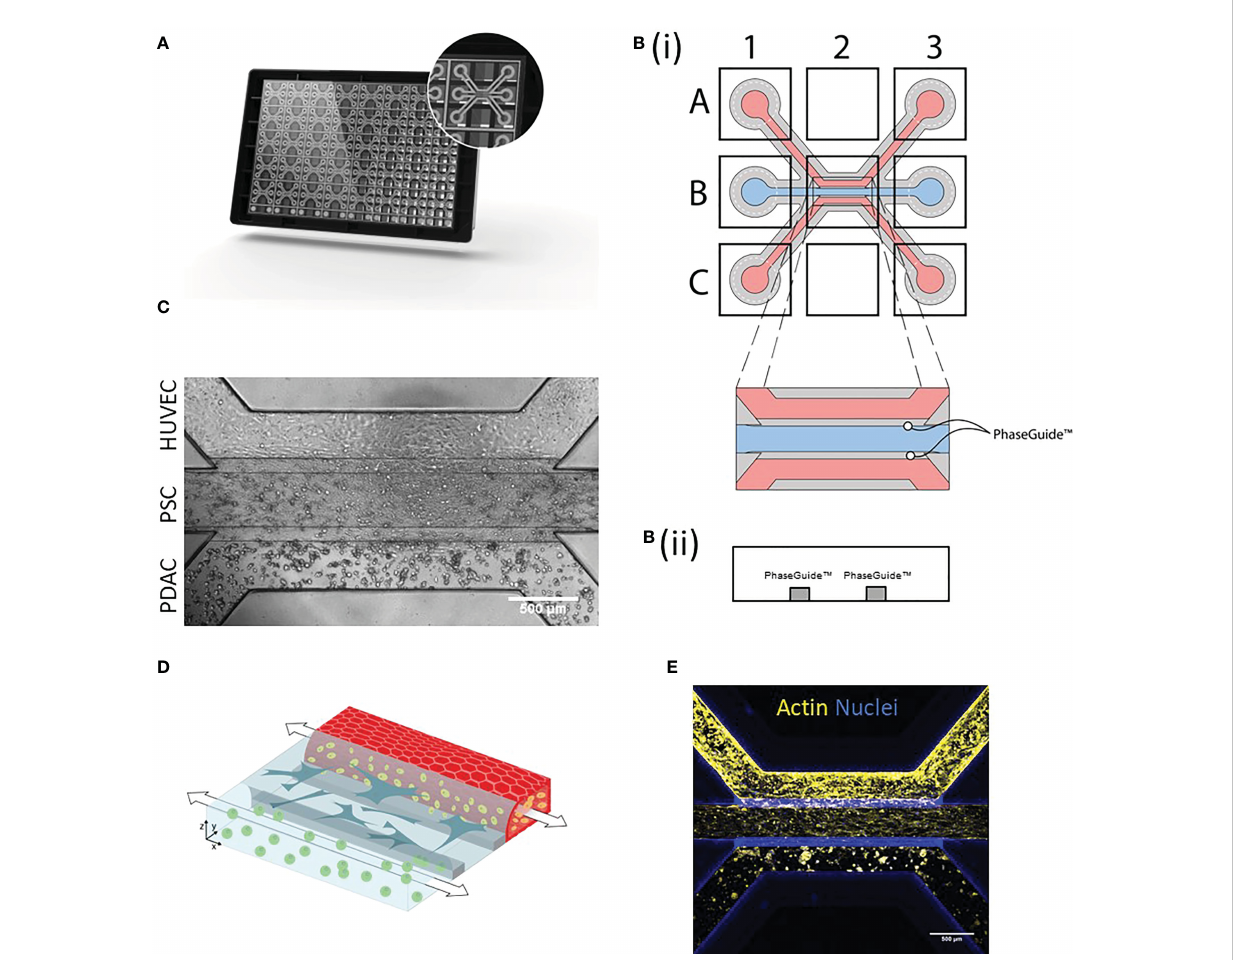
FIGURE 1 PDAC tumor microenvironment-on-a-Chip: (A) The OrganoPlate 3-lane comprises 40 chips with 3 micro fl uidic channels each. (B) (i). Endothelial cells were seeded into the top lane (A1) and due to capillary forces, the cells were distributed throughout the lane (A3) and allowed to form a tube. PSCs were loaded into the middle lane (B1) and PDAC organoids into the bottom lane (C1 distribution to C3). (B) (ii) Side view of a chip comprising the three lanes with PhaseGuides, that allowed for the compartmentalization of different cell types. Microscopic images were acquired from the observation window, which comprises all three lanes (B2) and which can be seen in (C) Phase contrast image shows culture organization in an OrganoPlate 3-lane chip. 4x acquisition, Scale bar=500 µm. Images acquired on the ImageXPress Micro XLS Wide fi eld High-Content Analysis System ® (Molecular Devices). (D) Schematic representation of the 3D culture, where PBMCs (yellow) migrated from the HUVEC tube (red) through the stroma (blue) to PDAC organoids (green). (E) Immunostaining with Actin (yellow) and NucBlue (blue). The cells were imaged on the confocal microscope. Shown are 4x maximum intensity projections, imaged on the ImageXpress Micro Confocal (Molecular Devices). Scale bar= 500